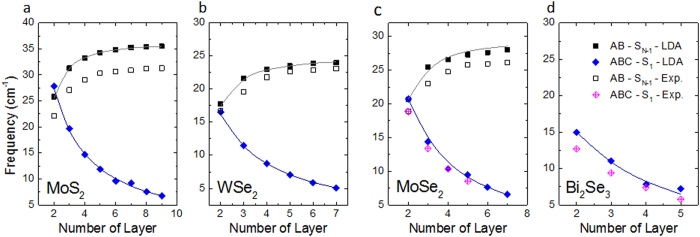
Frequency evolution trends of interlayer shear modes with largest Raman intensity in (a) MoS2, (b) WSe2, (c) MoSe2 and (d) Bi2Se3 with different stacking orders.The LDA calculated data are plotted with solid dots and the experimental data are shown in empty dots. The gray and indigo lines result from fitting of the largest frequency shear modes (SN-1) and the lowest frequency shear modes (S1) for AB and ABC stacking order, respectively, using the linear chain model12. The resulting force constants are shown in Table S10.